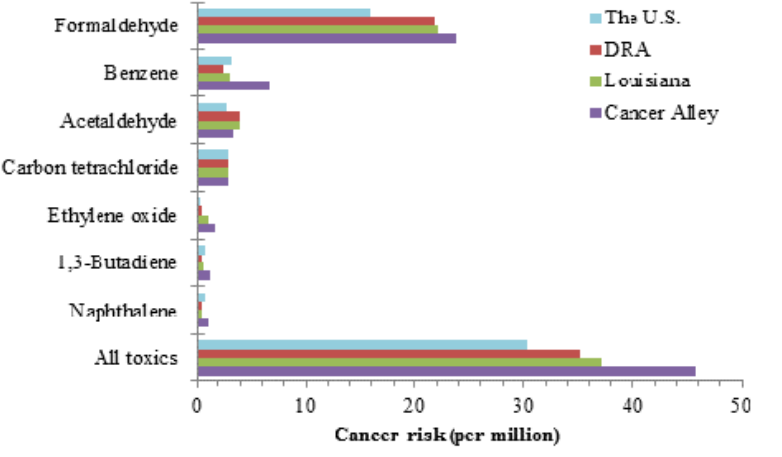
Figure 1. Comparison of mean cancer risks among the US, DRA, Louisiana and Cancer Alley.